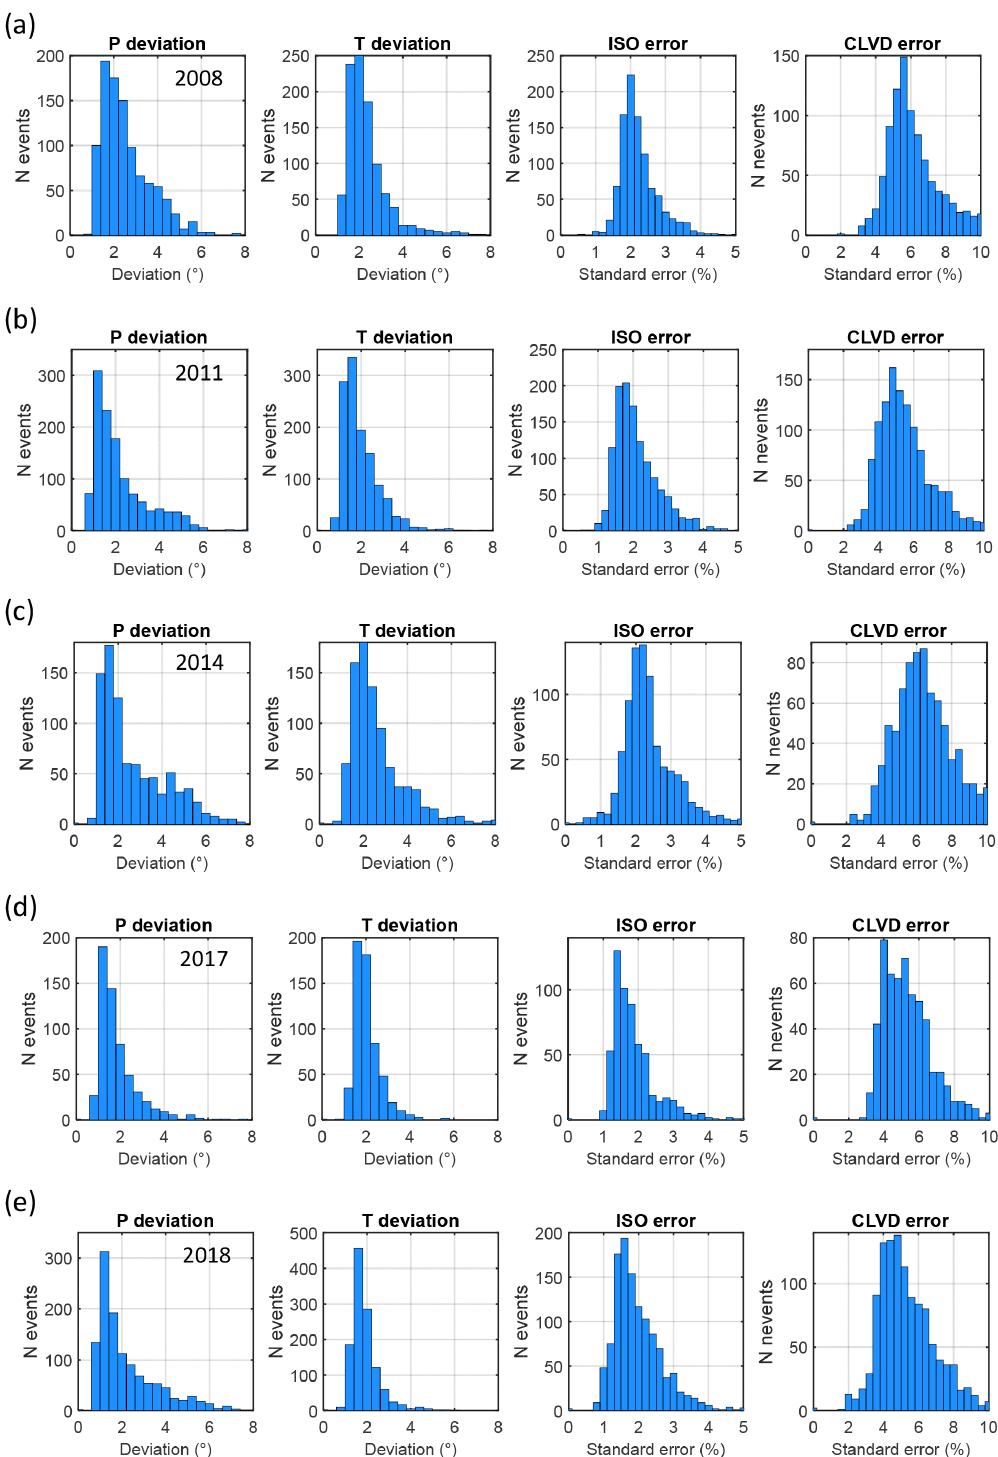
Figure 10. Histograms of mean deviations of the P/T axes and histograms of the ISO and CLVD standard errors for MTs of earthquakes from individual prominent seismic activities in 2008 (a) , 2011 (b) , 2014 (c) , 2017 (d) , and 2018 (e) . The mean P/T deviations and the ISO and CLVD standard errors were calculated for each event from 100MTs inverted using randomly generated noisy